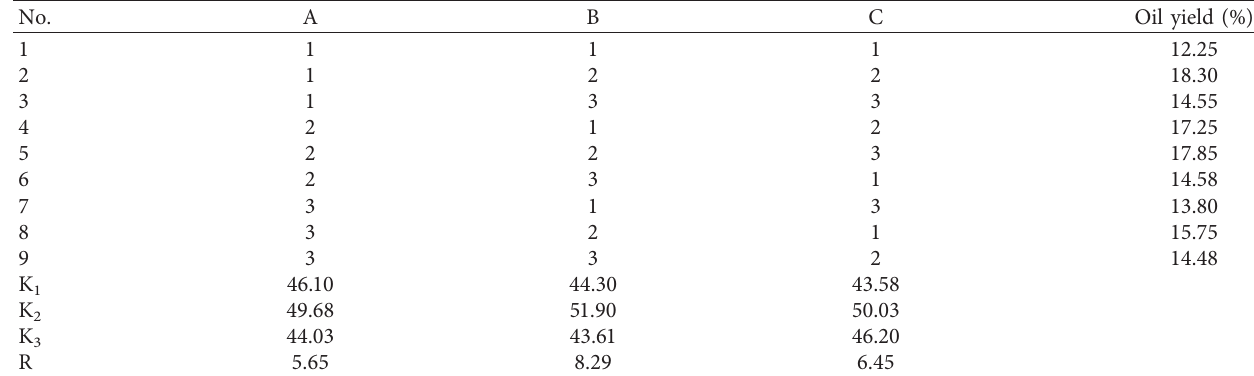
Table 6: Orthogonal design and results of supercritical extraction of palm seed oil.